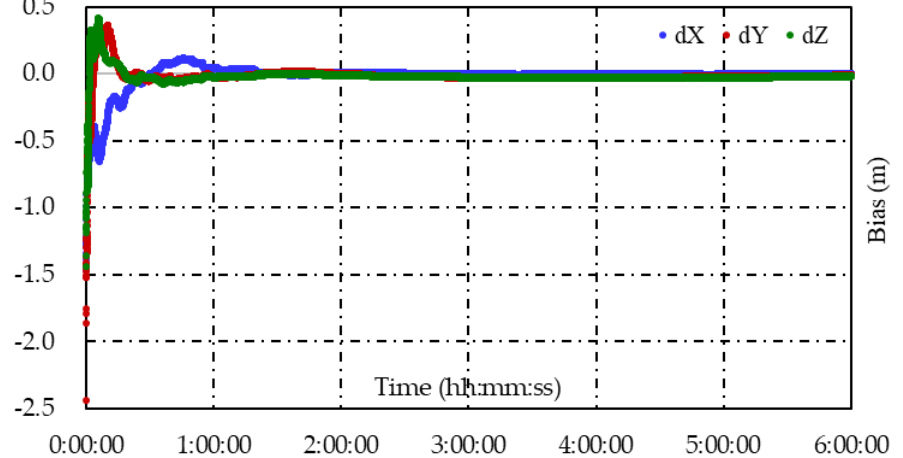
Figure 20. Coordinate biases from static PPP without MSJP correction.